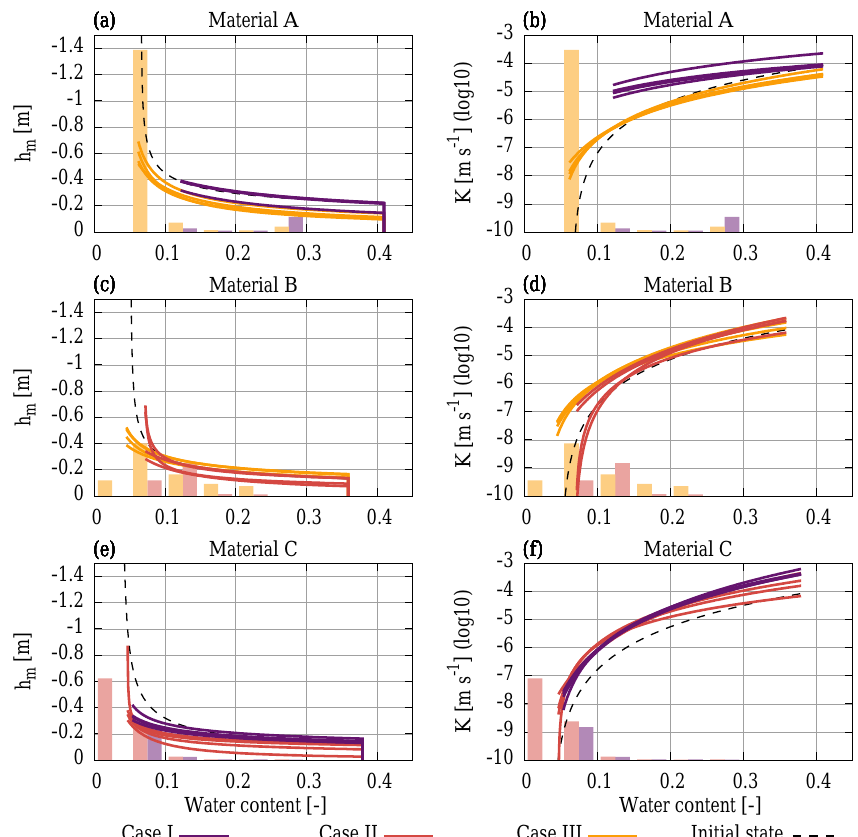
Figure 8. The estimated material functions of the best ensemble member are shown for each of the three cases (case I, case II, and case III) and the four setups of the 1-D study. Additionally, we present the material functions resulting from the initial state estimation (Sect. A1.6). The plot range is adjusted to the available water content range for all inversion results. The number of water content measurements within intervals of 0 . 05 is indicated with histogram bars for each case. The height of these bars is normalized over all figures in this work. The main message of this figure is that unrepresented model errors may lead to biased hydraulic parameters. In particular, this can be seen by comparing the hydraulic conductivity K of material A for cases I and